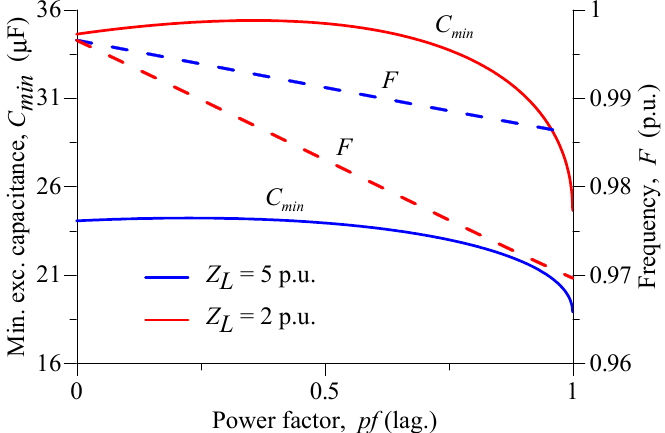
Figure 8. Variation of minimum excitation capacitance C min and frequency F versus power factor pf for different loads at fixed speed ( u = 1.0 p.u.).